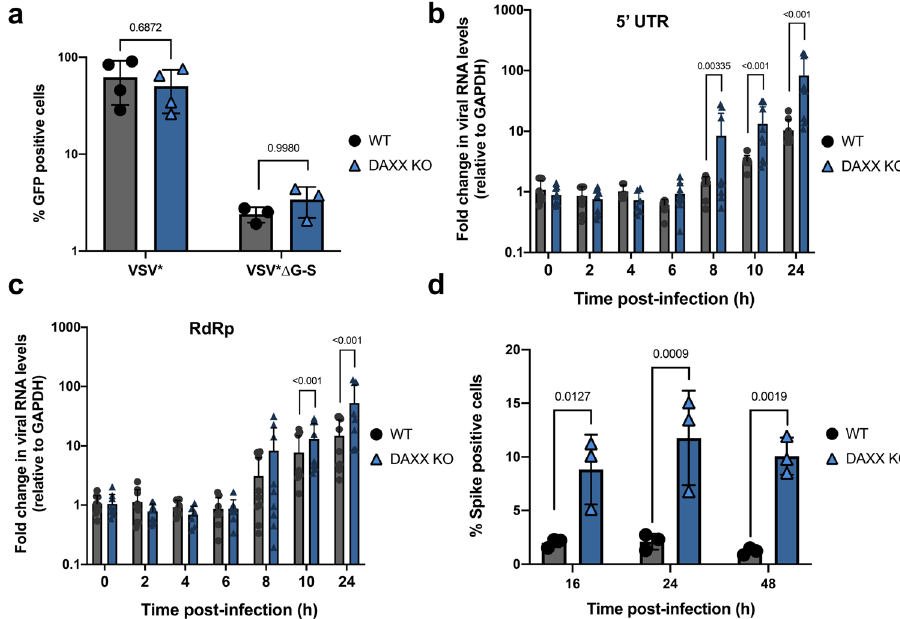
Fig. 3 DAXX inhibits SARS-CoV-2 at an early post-entry step. a DAXX has no effect on Spike-mediated entry. A549-ACE2 WT or DAXX KO were infected with the GFP reporter viruses VSV* or VSV* Δ G-S. Cell monolayers were harvested at 16h p.i. and analyzed by fl ow cytometry. The mean of 3 independent experiments ±SD is shown. Statistics: 2-way ANOVA using Sidak ’ s test. P values are indicated on the graph . b , c DAXX inhibits viral RNA synthesis. A549-ACE2 WT or DAXX KO were infected at an MOI of 1. Cell monolayers were harvested at the indicated time points, and total RNA was extracted. The levels of viral RNA ( c : 5 ʹ UTR; d : RdRp) were determined by qRT-PCR and normalized against GAPDH levels. The mean ± SD of 3 independent experiments, with infections carried out in three biological replicates, is represented. Statistics: Dunnett ’ s test on a linear model (two-sided). Signi fi cant p values (below 0.05) are indicated on the graph. d DAXX inhibits viral protein synthesis. A549-ACE2 WT or DAXX KO were infected at an MOI of 2. Cell monolayers were harvested at the indicated time points and Spike levels were quanti fi ed by fl ow cytometry. The mean of 3 independent experiments± SD is represented. Statistics: 2-way ANOVA using Sidak ’ s test. P values are indicated on the graph. Source data are provided as a Source Data fi